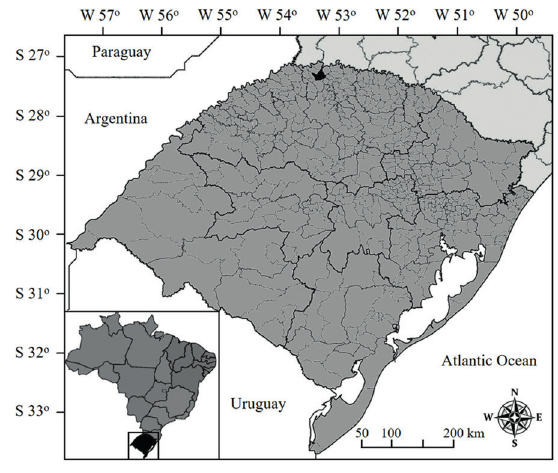
Figure 1 - geographical location of the experiment. The State of rio grande do Sul is highlighted in black on the bottom map, while the city of Frederico Westphalen is highlighted in black on the main